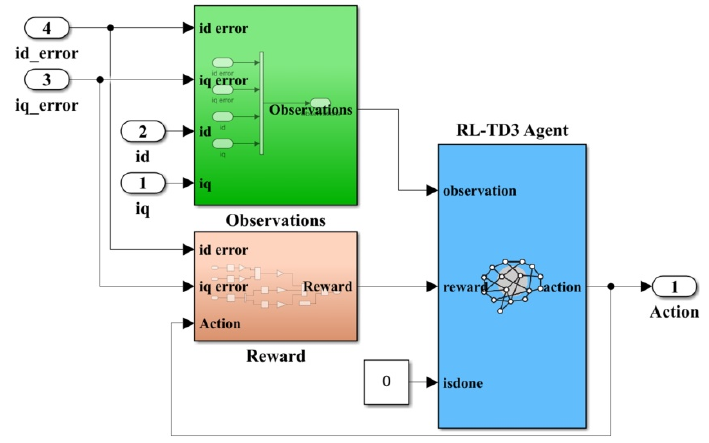
Figure 11. The model MATLAB Simulink implementation of the control system for the GC-PV ar- ray based on PI controllers using the RL-TD3 agent for the correction of the u dref and u qref commands.